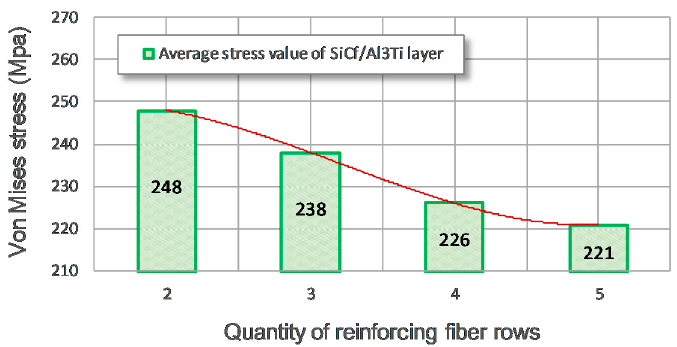
Figure 27. The average stress value of the SiC f /Al 3 Ti layer for the four stress fields with different quantities of reinforcing fiber rows.